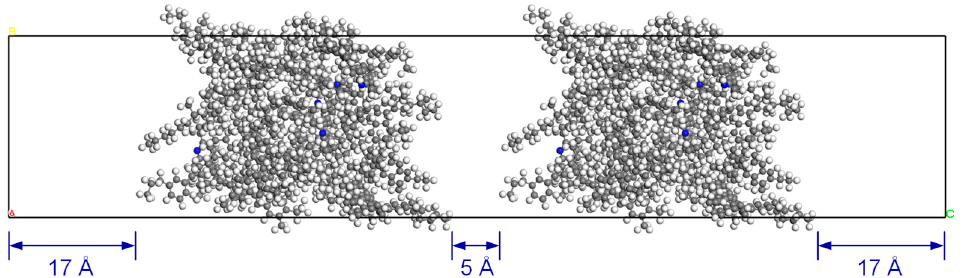
Figure 5. Geometry of the diffusion model.